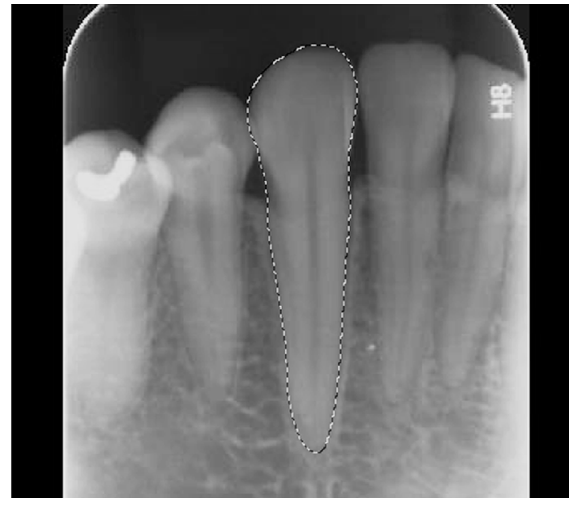
Figure 5. Use of a histogram to verify the number of pixels in the